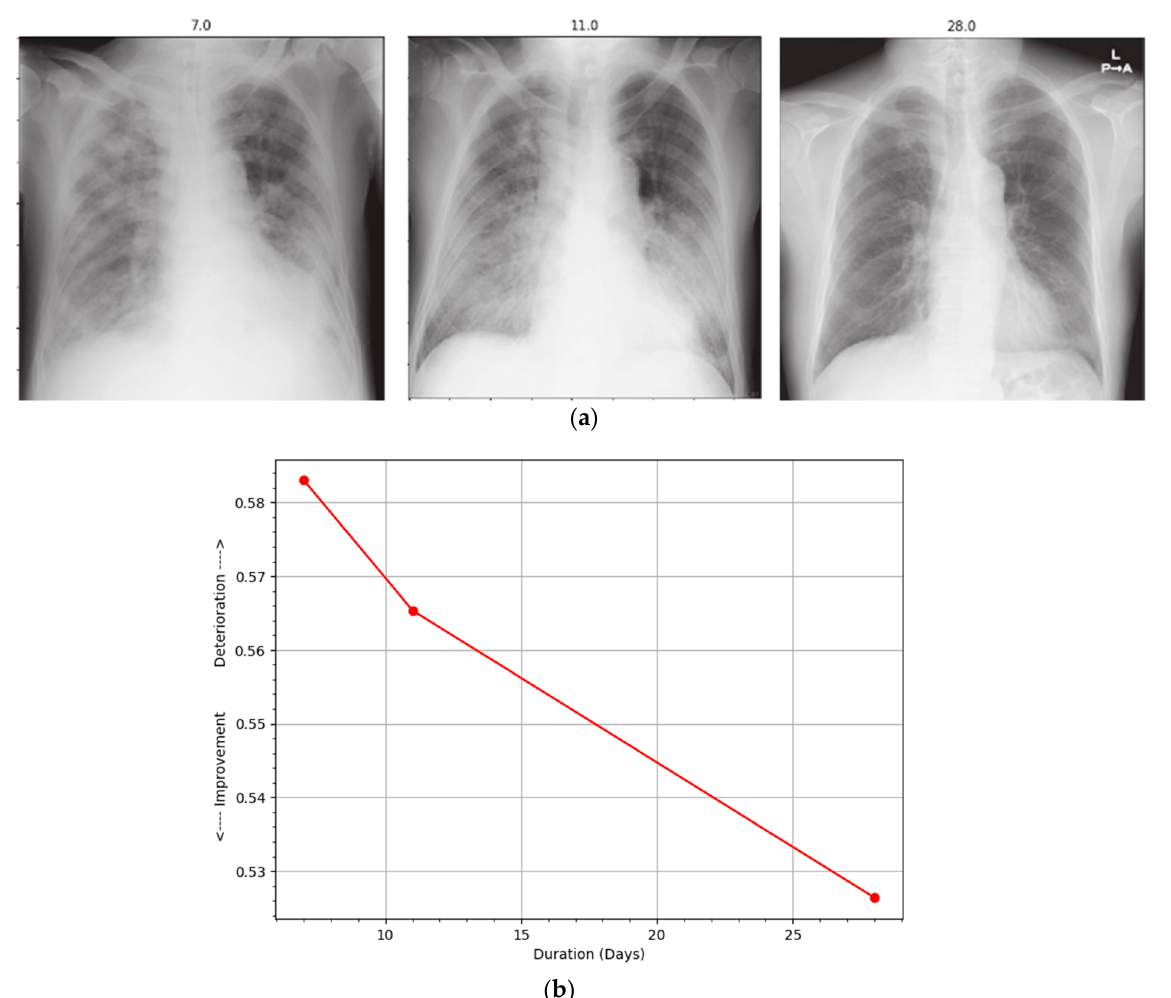
Figure 5. ( a ) Subsequent radiographs belonging to a patient (173) who exhibited deterioration till day 9 but showed improvement on day 10, which is reflected in ( b ) the disease progression profile (red line). The patient was intubated but survived the infection.